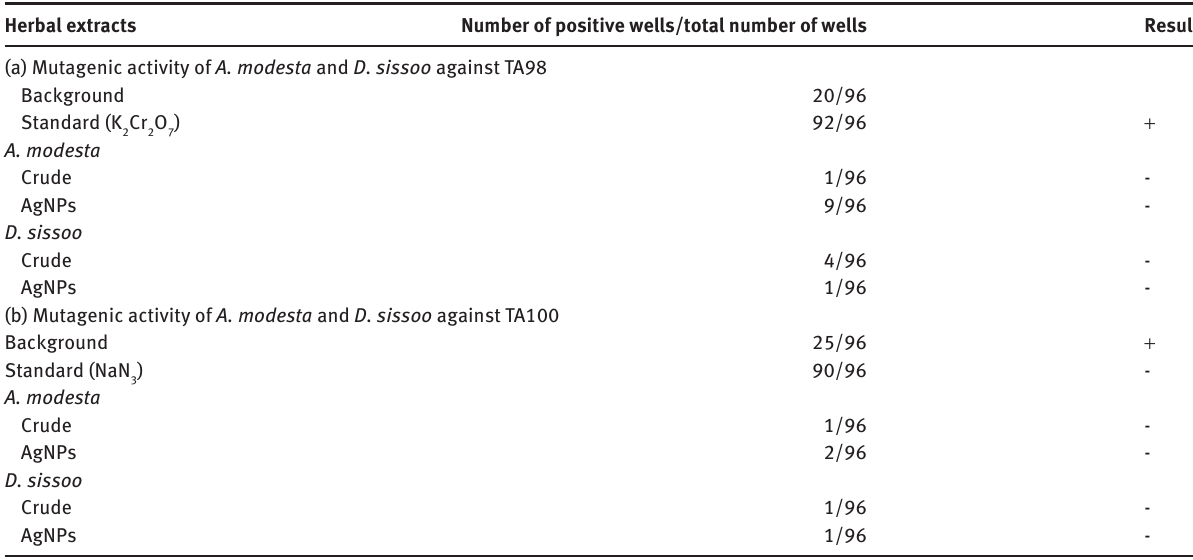
Table 4: Mutagenic activity of A. modesta and D. sissoo against TA98 and TA100. Herbal extracts Number of positive wells/total number of wells